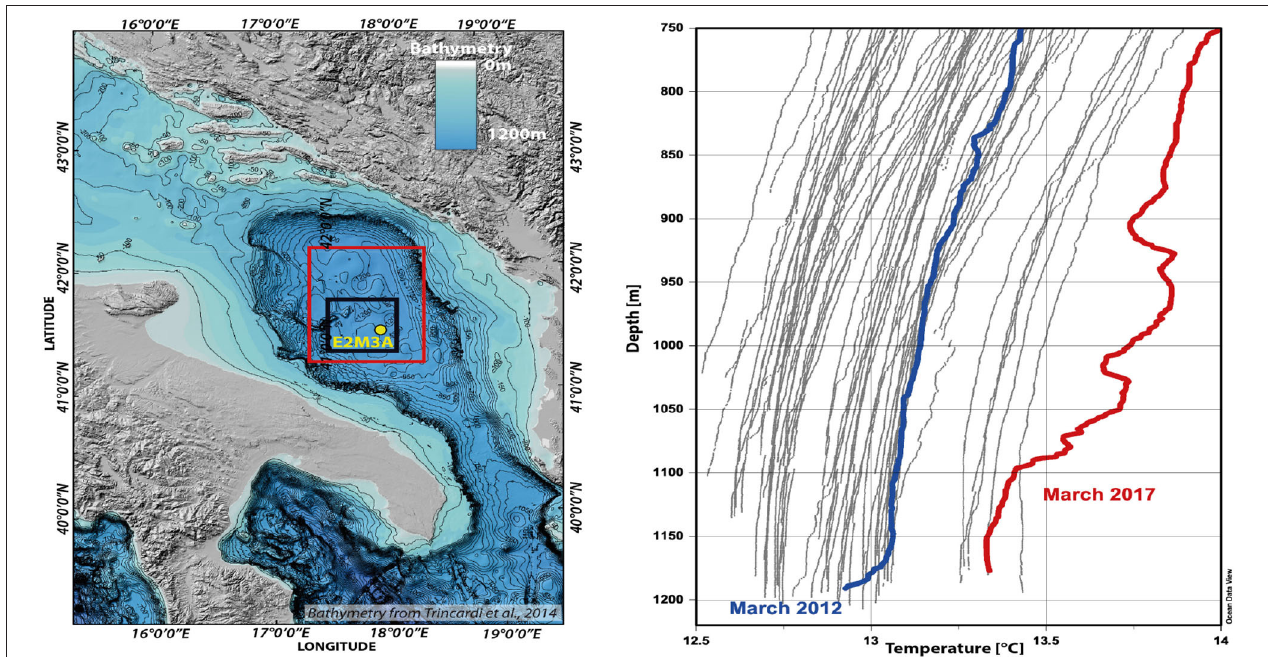
FIGURE 1 | (Left) Region of the South Adriatic Pit (SAP). The red rectangle shows the area where all the profiles originated. After 2010, data were collected within the black rectangle. The yellow dot indicates the position of the E2M3A observatory of the thermohaline time series. (Right) All 55 profiles of the temperature dependence with the depth. The two profiles during the deep convection/gravity current events are emphasized in blue and